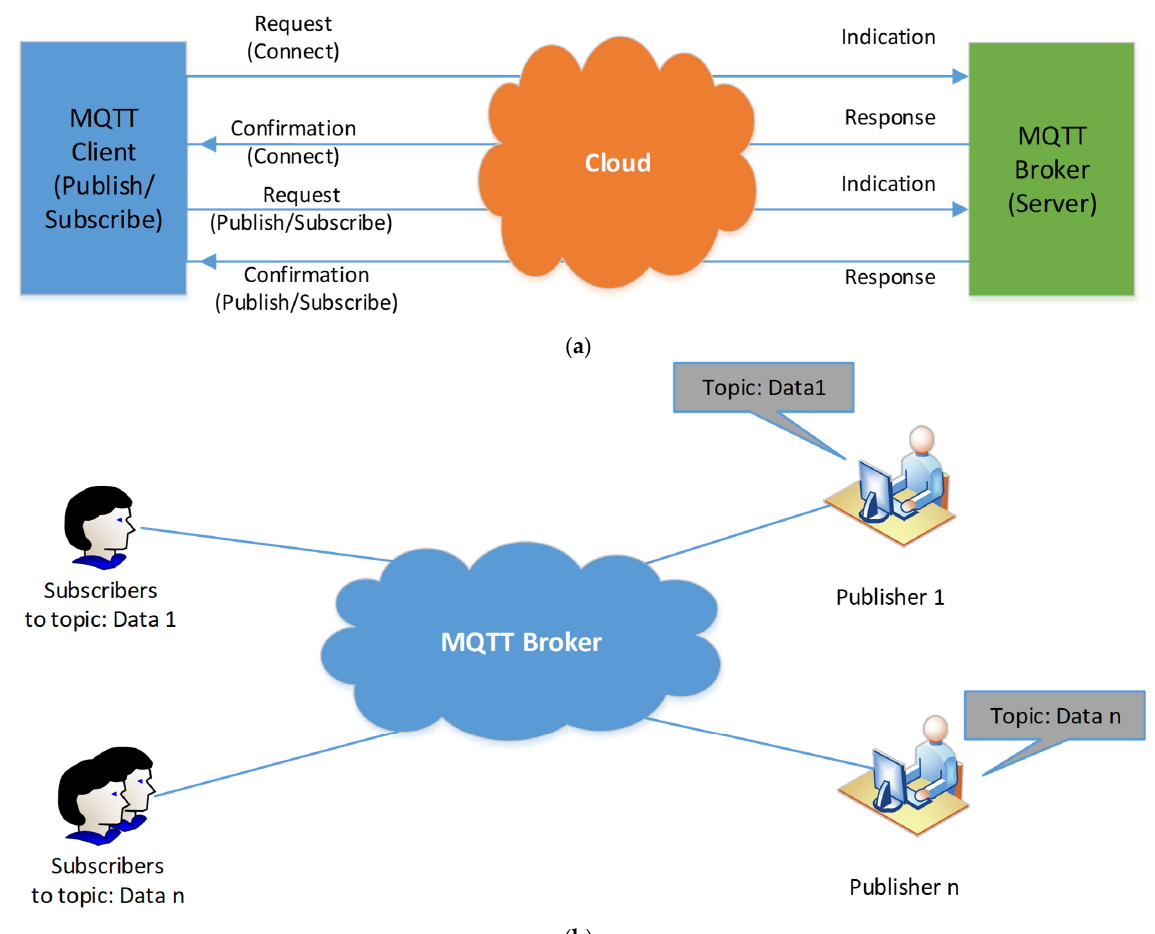
Figure 6. ( a ) Procedure of MQTT; ( b ) MQTT component and topic.